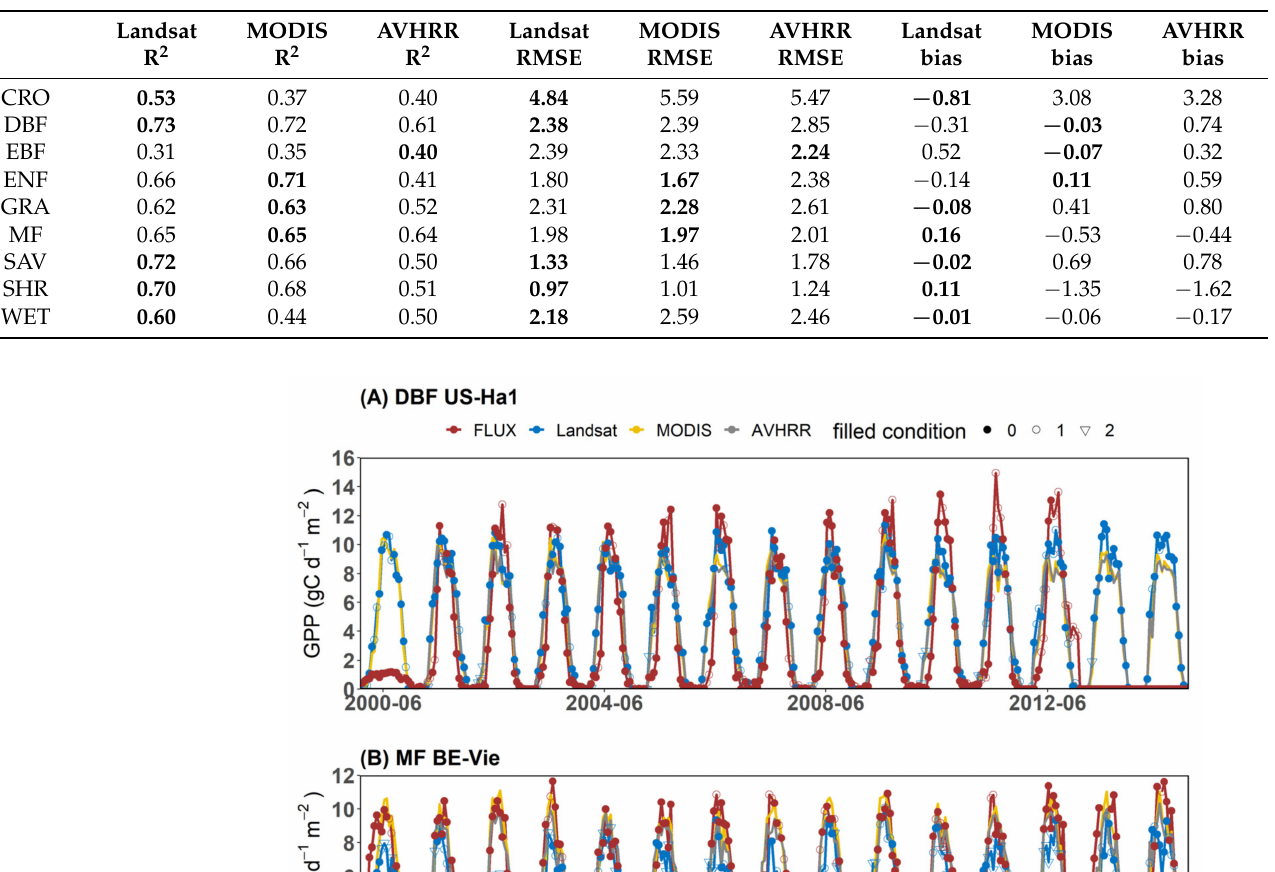
Table 4. GPP validation for different vegetation types. Bold indicates the best statistic. The unit of RMSE and bias is g C m − 2 d − 1 .